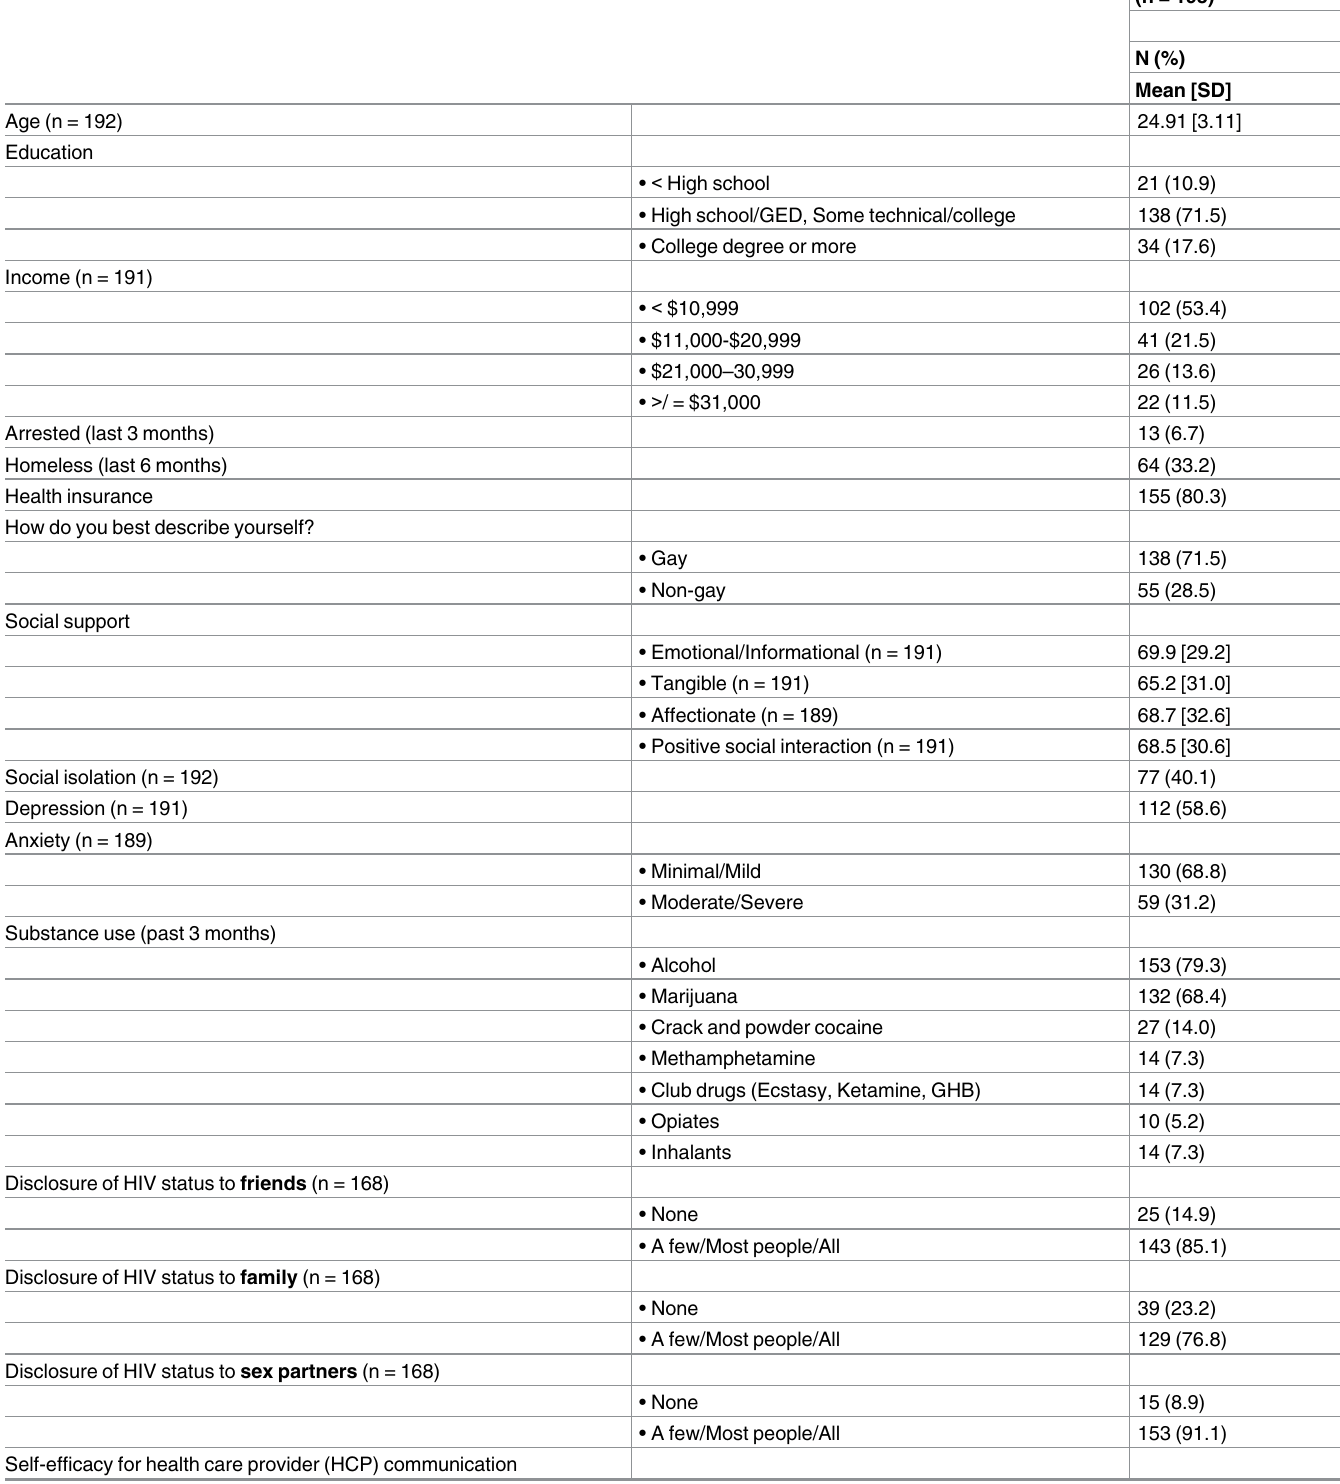
Table 1. Descriptivestatistics of HIV-positive HMP participants at study